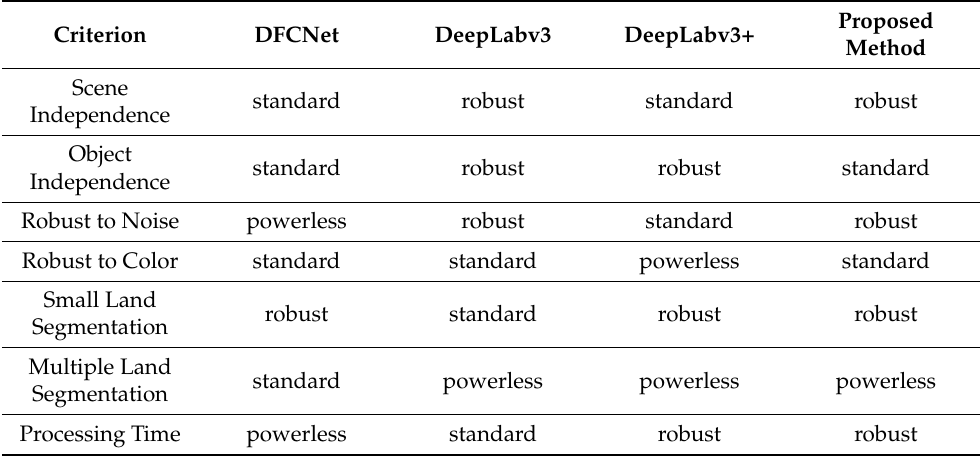
Table 5. Evaluation of the robustness and weaknesses of segmentation methods using different